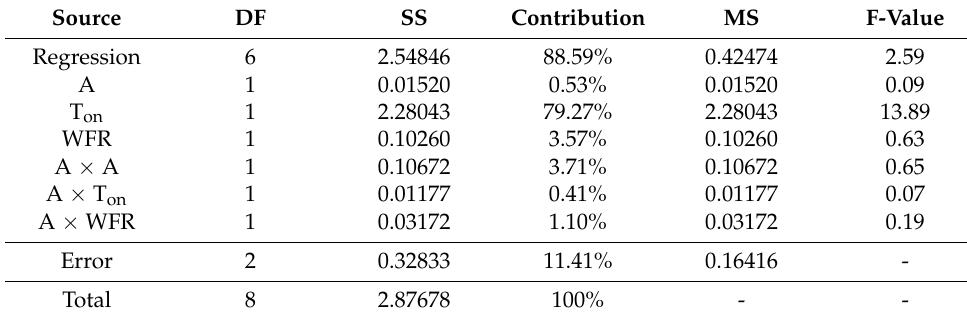
Table 6. Analysis of variance: surface roughness—Al6351–5% SiC–5% B 4 C.